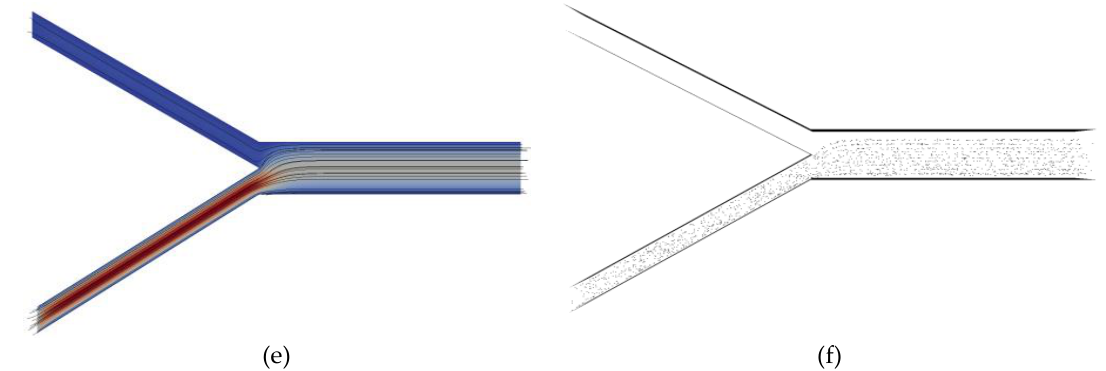
Figure 2. Streamlines (left) and snapshots of the particles positions (right) for θ = 60° and (a ,b) Vp/Vc = 0.5, (c,d) Vp/Vc = 10, and (e,f) Vp/Vc = 20.